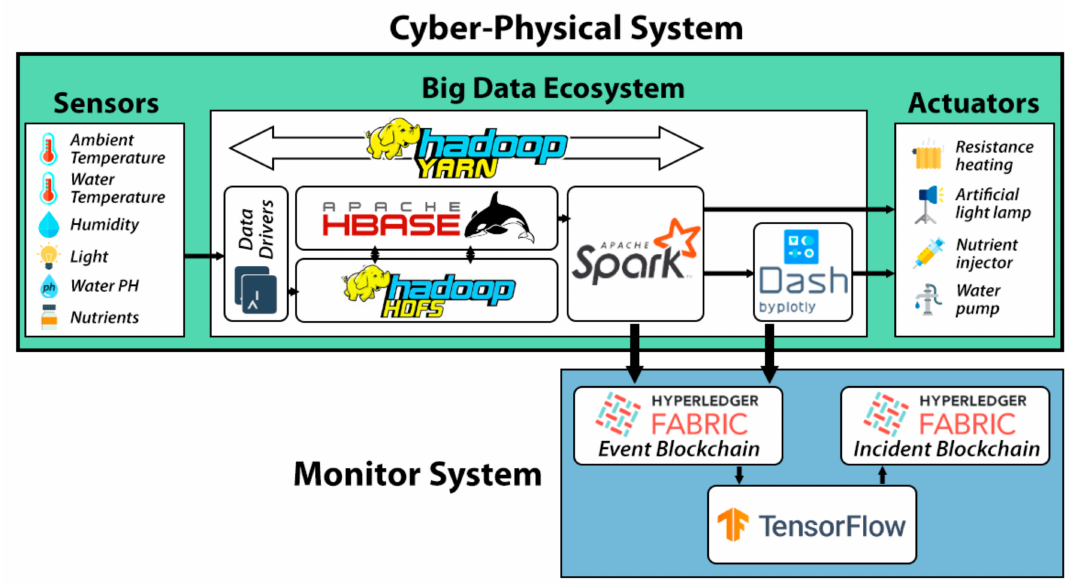
Figure 7. Technological